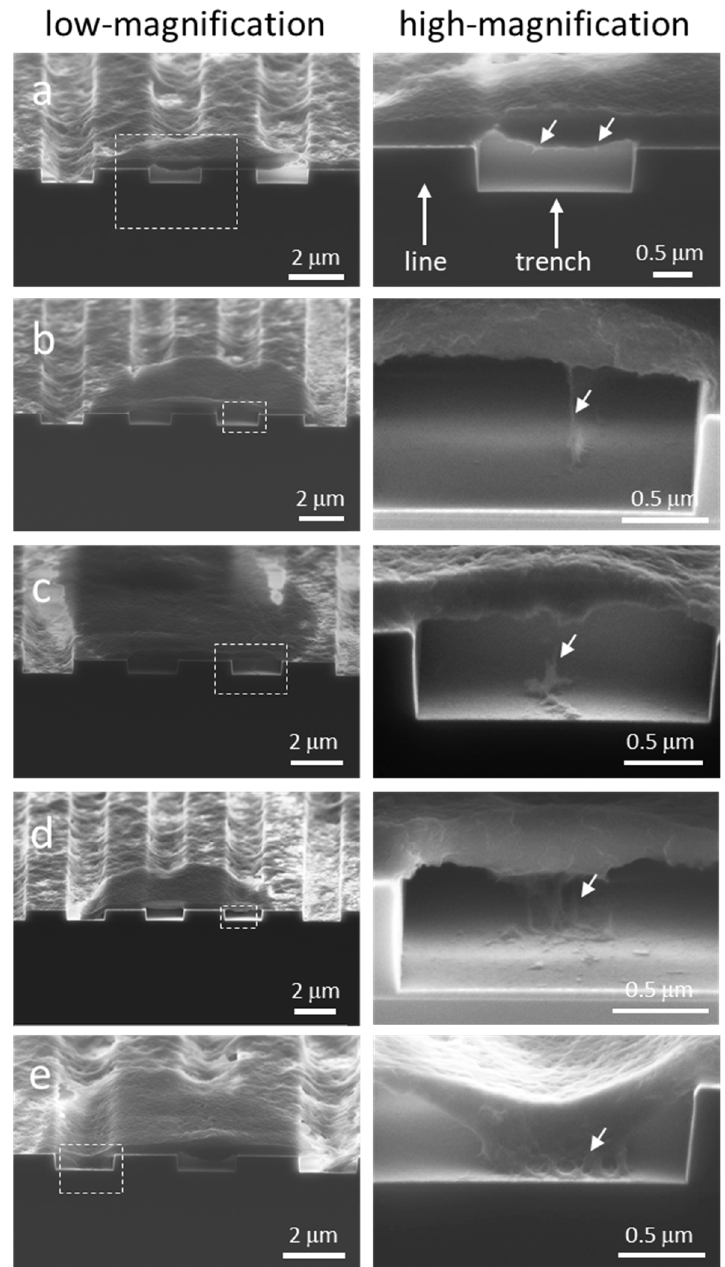
Figure 8. Micrographs of dissected cells show different amounts of cellular material descending into the 2 µ m trenches. The size of filament cluster or fibrous structures that connect the cell underbelly to the substrate increased as more materials sunk into the trench. ( a ) Short filaments protruding out of the cell underbelly but that did not attach to any surface; ( b -c ) single-strand filaments from the cell underbelly attached to the bottom of trenches; ( d ) a cluster of filaments connected the cell underbelly and the bottom of trenches; ( e ) a large network of fibrous structures is formed between the cell and the trench bottom surfaces.